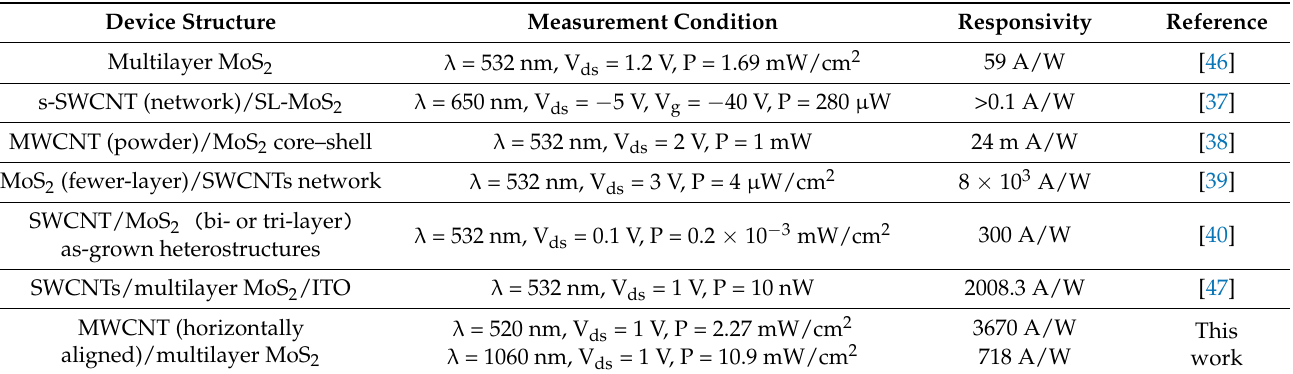
Figure 6. ( a ) Schematic illustration of the bare MoS 2 photodetector; ( b ) I ds -V ds curves of the bare MoS 2 photodetector at V g = 0 V with different laser powers at V ds = 0 V; ( c ) I ds -V ds curves of the bare MoS 2 photodetector at V g = 0 V with different laser powers at V ds = 0.01 V; ( d ) variation in the device response time at V ds = 0.01 V with an optical power of 5.8 mW/cm 2 illumination. Table 1. Comparison of the responsivity values of MoS 2 and CNT-MoS 2 photodetectors.